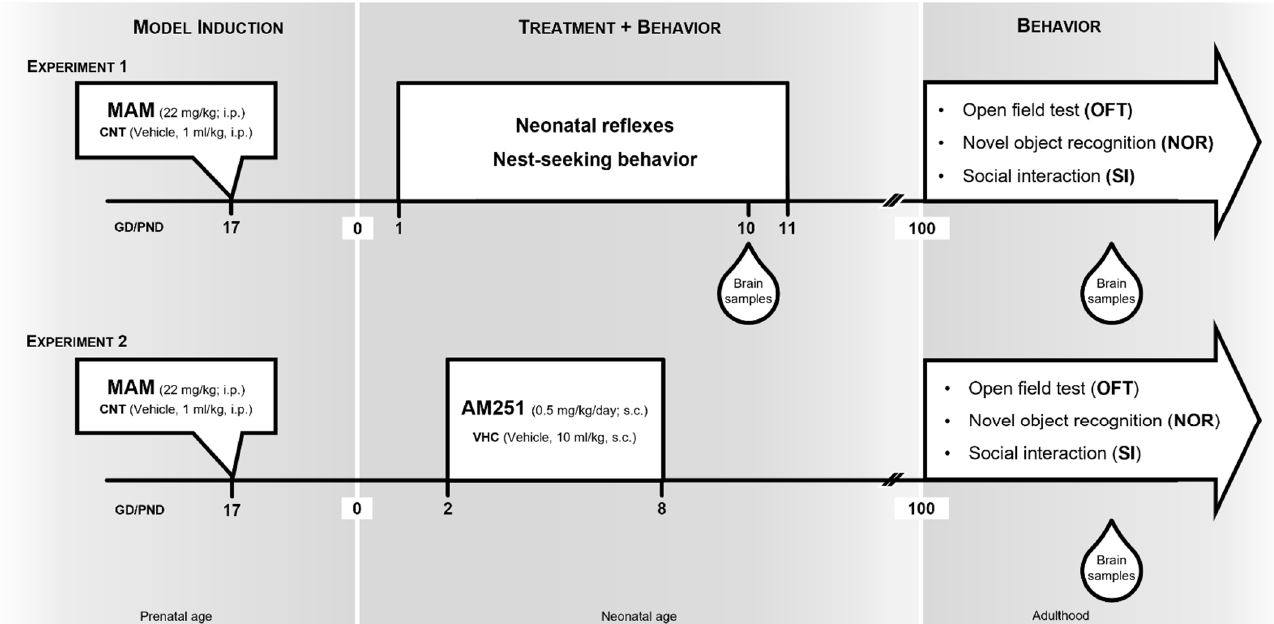
Figure 1. Experimental design that was used to investigate the effects of early pharmacological cannabinoid CB1 receptor blockade in MAM model of schizophrenia. Experiment 1: pregnant rats were exposed to methylazoxymethanol (MAM) acetate (22 mg/kg; i.p.) or saline (CNT: 1 mg/kg; i.p.) on gestational day (GD) 17. The resulting male offspring were subjected to behavioral tests at two different time points [neonatal age from postnatal day (PND) 1 to PND 11 and adulthood from PND 100], followed by neurochemical analysis. Experiment 2: pregnant rats were exposed to MAM acetate (22 mg/kg; i.p.) or saline (CNT: 1 mg/kg; i.p.) on GD 17. The resulting male offspring were treated from PND 2 to PND 8 with vehicle (VHC) or AM251 (0.5 mg/kg/day; s.c.). Behavioral and neurochemical analysis of the offspring were conducted at adulthood from PND 100.